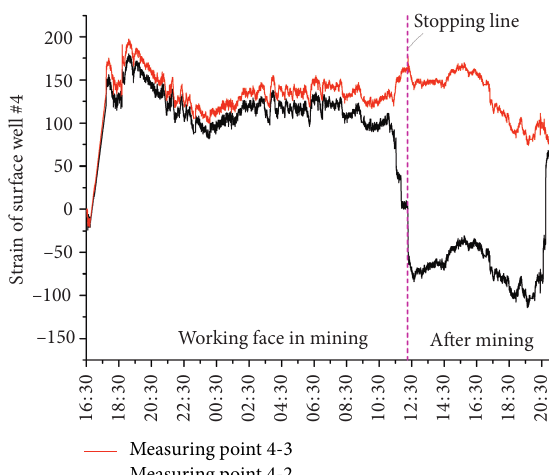
Figure 15: Strain of surface well #4 at 77.75m (measuring point 4-2) and 155.8m (measuring point 4-3) above the coal seam (tensile strain is positive and compressive strain is negative).